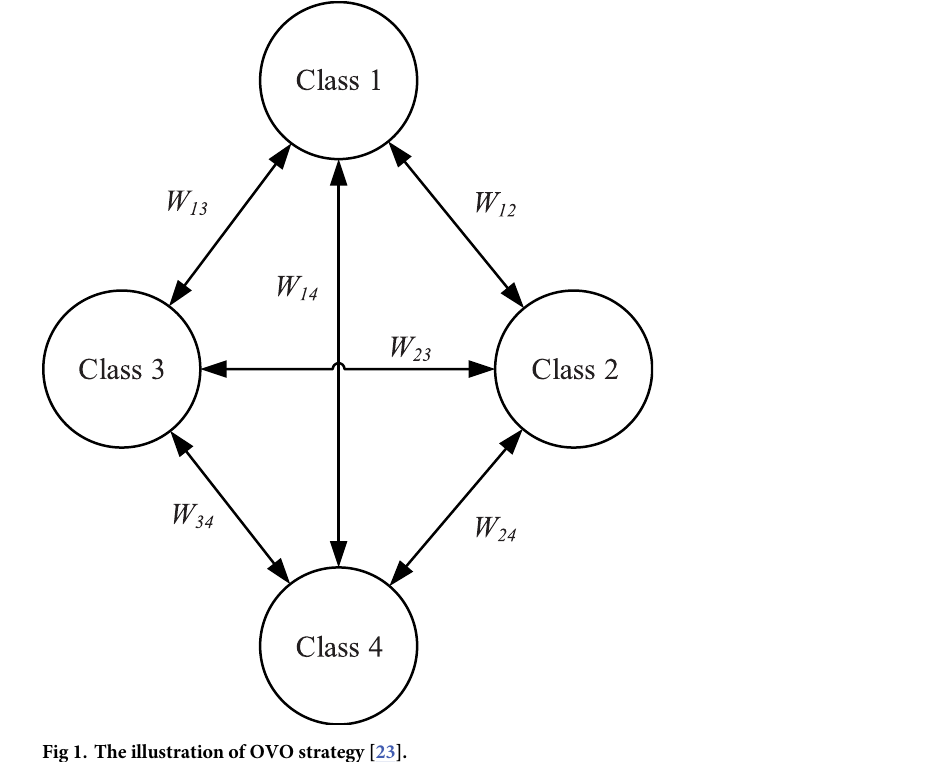
Fig 1. The illustration of OVO strategy